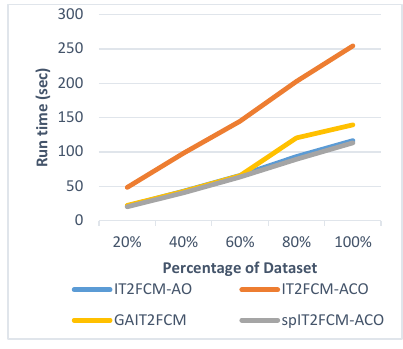
Figure 8. Analysis of run time for different percentages of sea dataset.